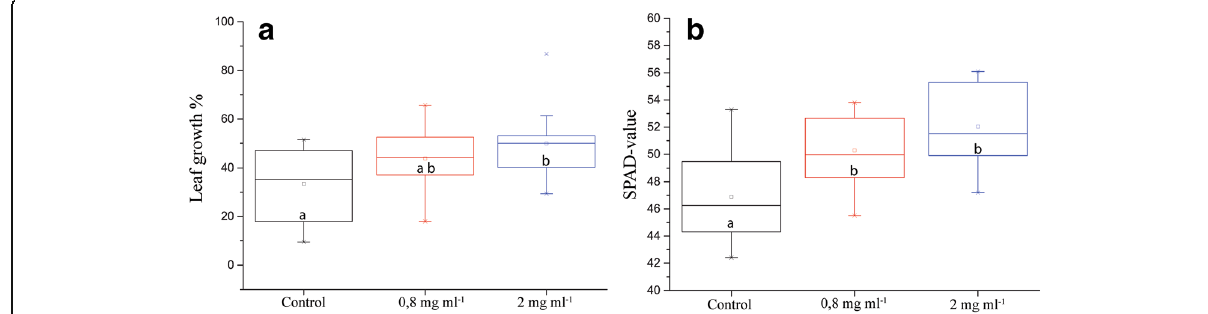
Fig. 1 Different physiological parameters of plants grown in pots with soil irrigated with nutrients or nutrients containing IONs. a Individual leaf length increase from before until after 5 days of ION-treatment ( n = 16, p value = 0.053). b Chlorophyll content in the leaves, as measured with